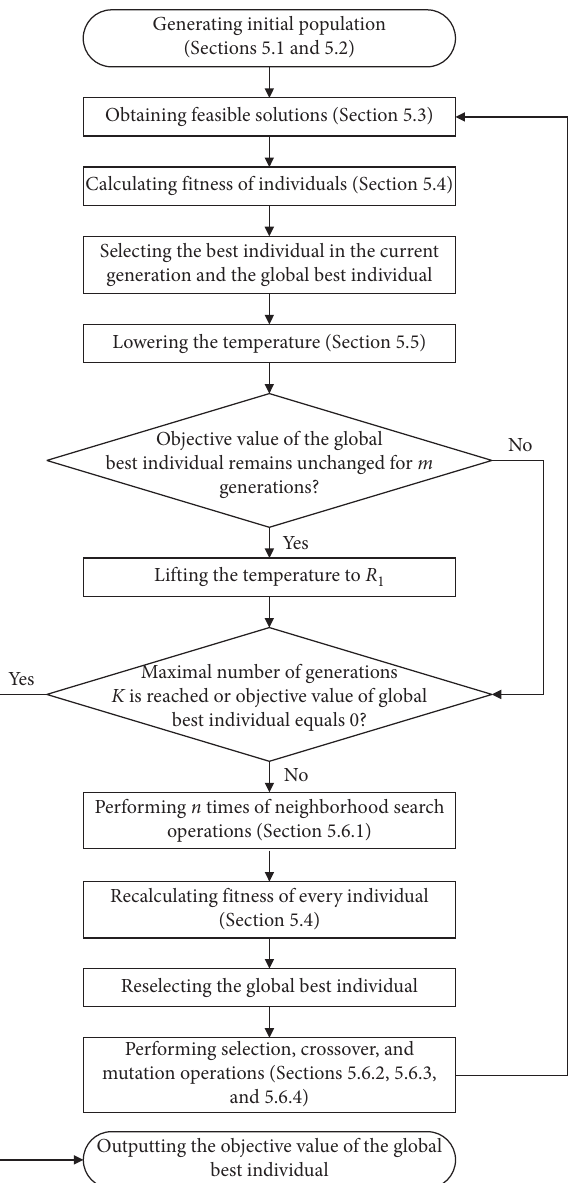
Figure 4: Solution framework of the GSAHA algorithm.